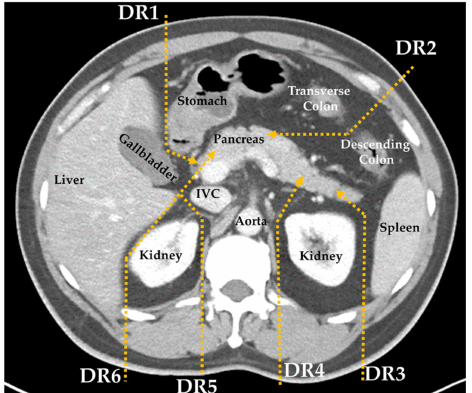
Figure 1. Diagram of the six major fat-transversing routes: Detour Route 1 (DR1) to pass between the stomach and gallbladder for head lesion; DR2 to pass through the splenic flexure space between the transverse and descending colon for body lesions; DR3 and DR4 to bypass the left kidney and spleen for body and tail lesions; and DR5 and DR6 to bypass the liver, right kidney, and inferior vena cava (IVC) for head or uncinate process